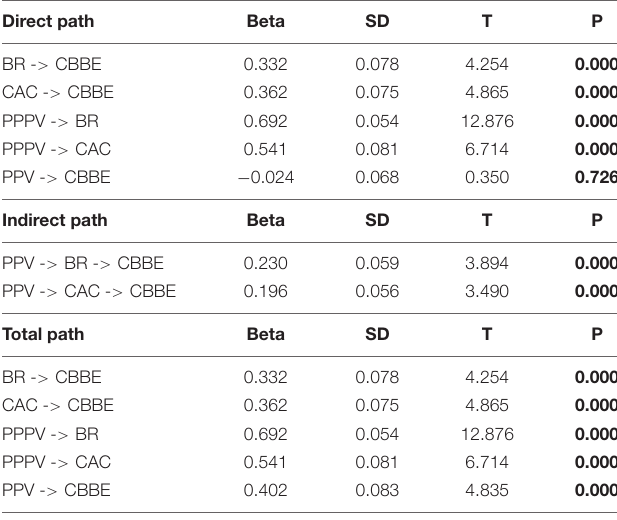
TABLE 4 | Direct, indirect and total path estimates.